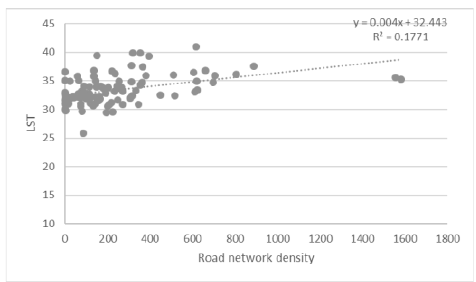
Figure 6. LST-Road network